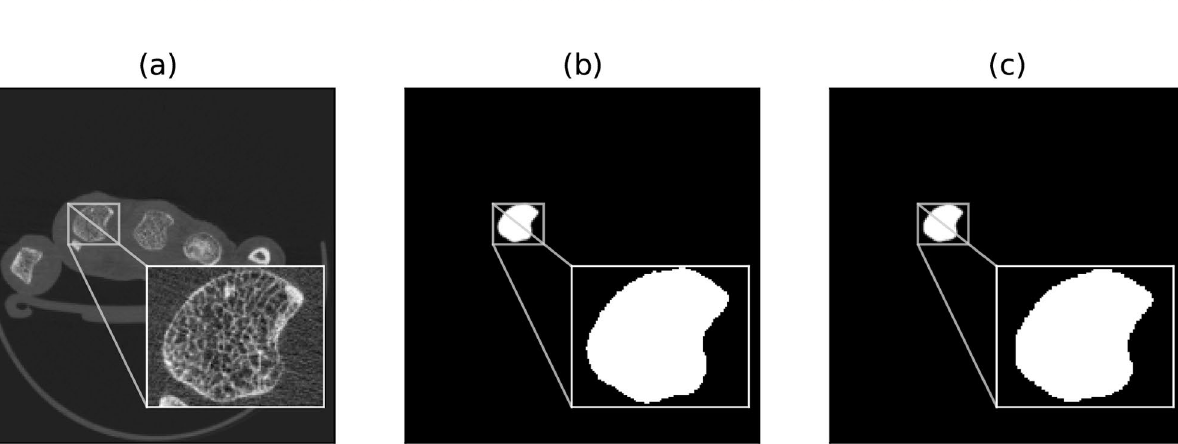
Table 1. Comparison of the metrics on the test set consisting of 54 patients for the three network configurations. Mean values are followed by standard deviation in brackets. The 2D U-Net (pre-trained) is trained once, the two other configurations are trained three times with different random seeds. Best metrics are highlighted in bold font.